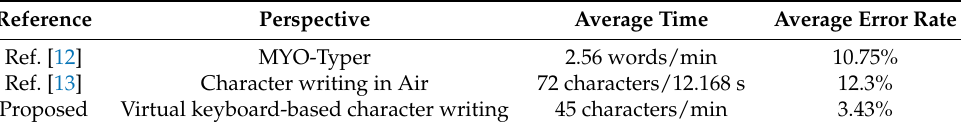
Table 7. Performance comparison of character inputs with state-of-the-art